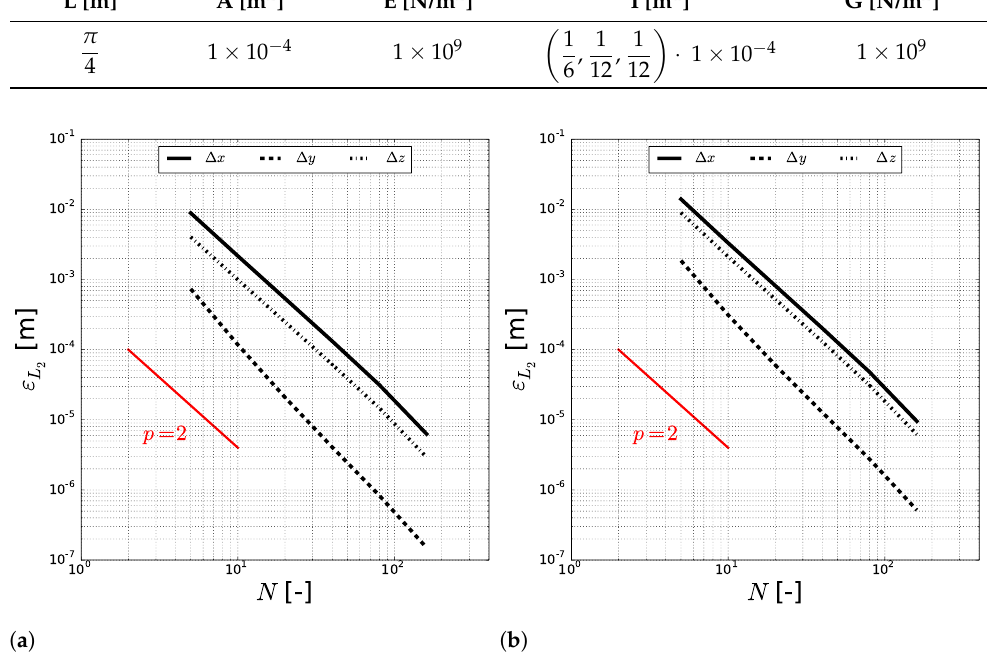
Figure 3. Convergence of the L 2 norm of error for the end position of the deformed rod. The solution for N = 320 is taken as the exact solution here. The red line corresponds to a convergence rate of p = 2. ( a ) Case with a 3 N load. ( b ) Case with a 6 N load.